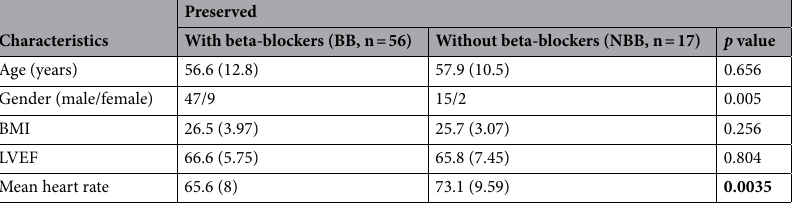
Table 1. Demographic characteristics. Data are expressed as mean (SD) for continuous variables and n for categorical, BMI Body mass index (kg/m 2 ), LVEF left ventricular ejection fraction(%). Significant value are in